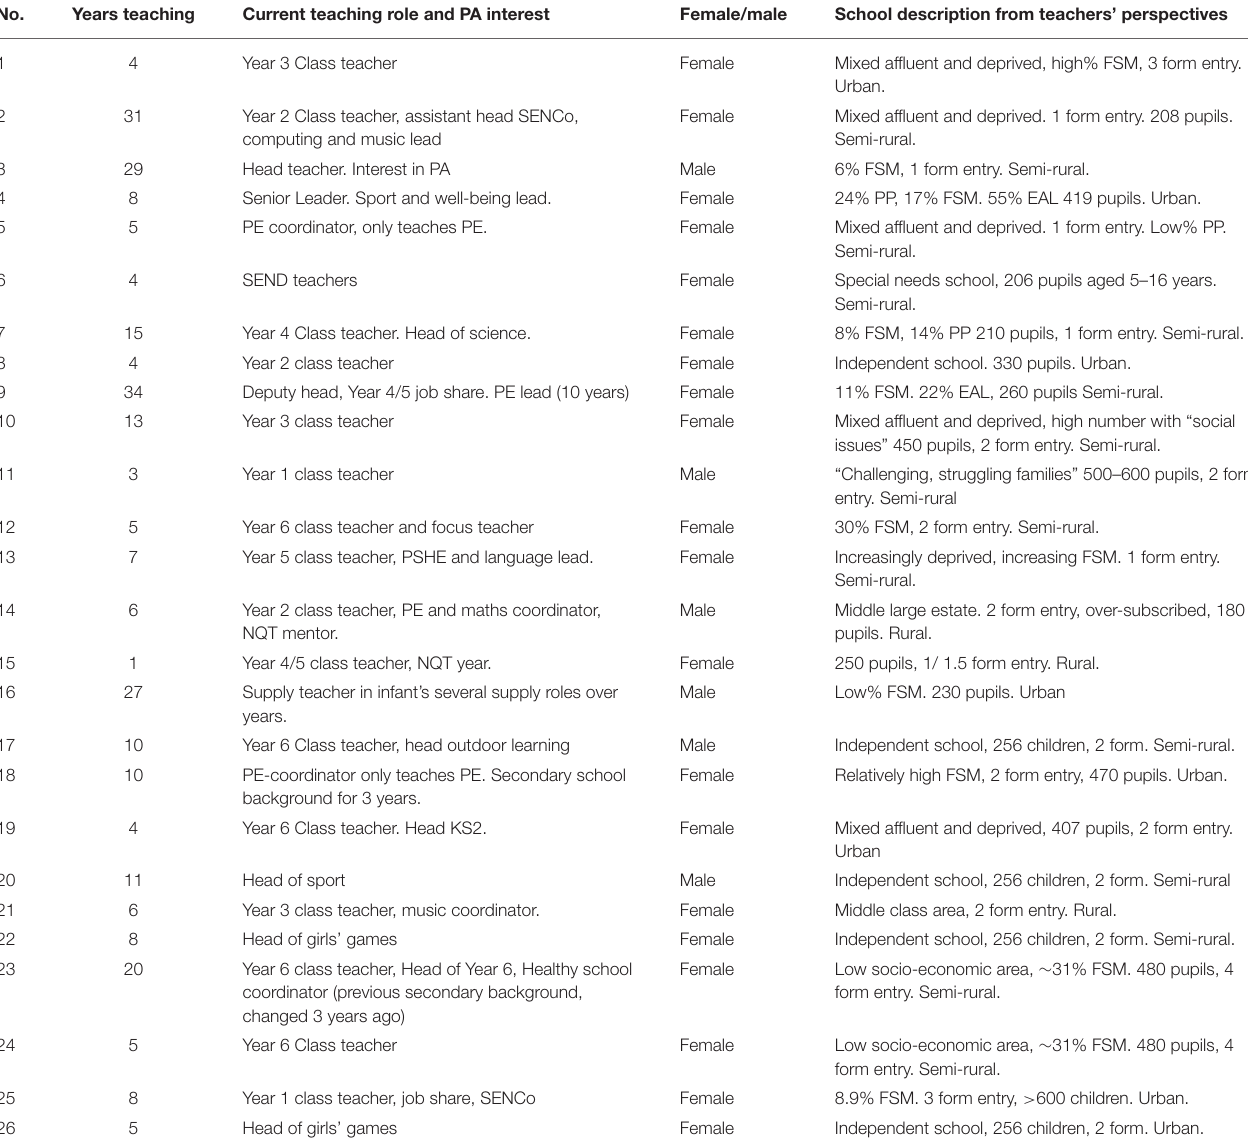
TABLE 2 | Comparison of teachers interviewed within the sample.